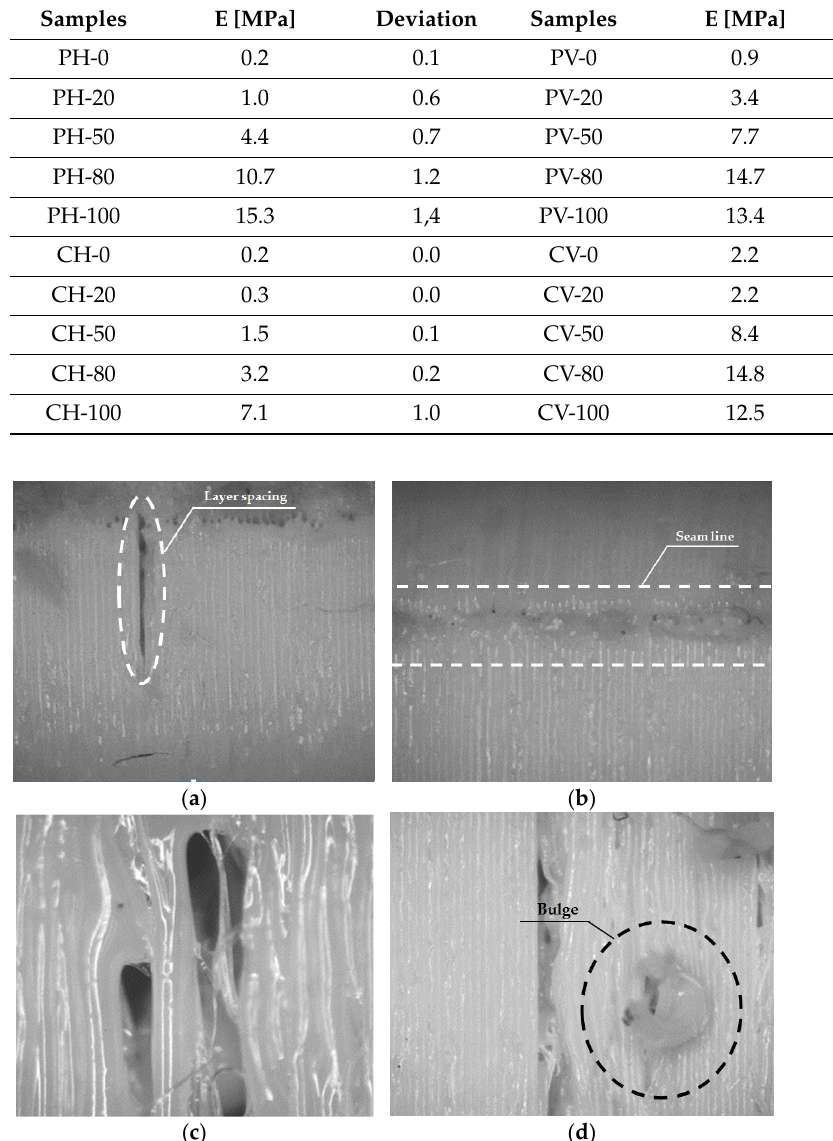
Figure 4. Details of manufacturing defects in specimens: ( a ) 80% filling–CH–Layer spacing; ( b ) 80% filling–CV–Seam line; ( c ) 0% filling–PH–Gap; ( d ) 20% filling–PV–Bulge. filling–CV–Seam line; ( c ) 0% filling–PH–Gap; ( d ) 20%